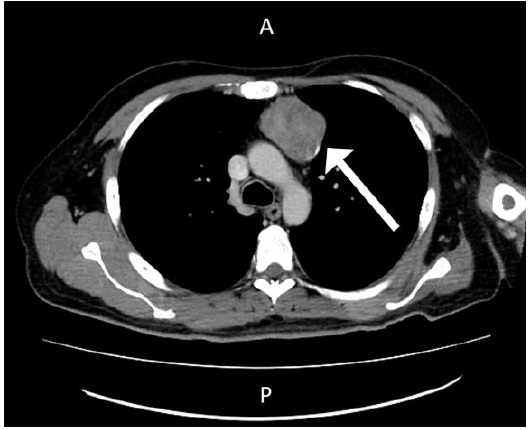
Figure 3. Computed Tomogram Scan with contrast at Chest revealed mass lesion over anterior mediastinum region.